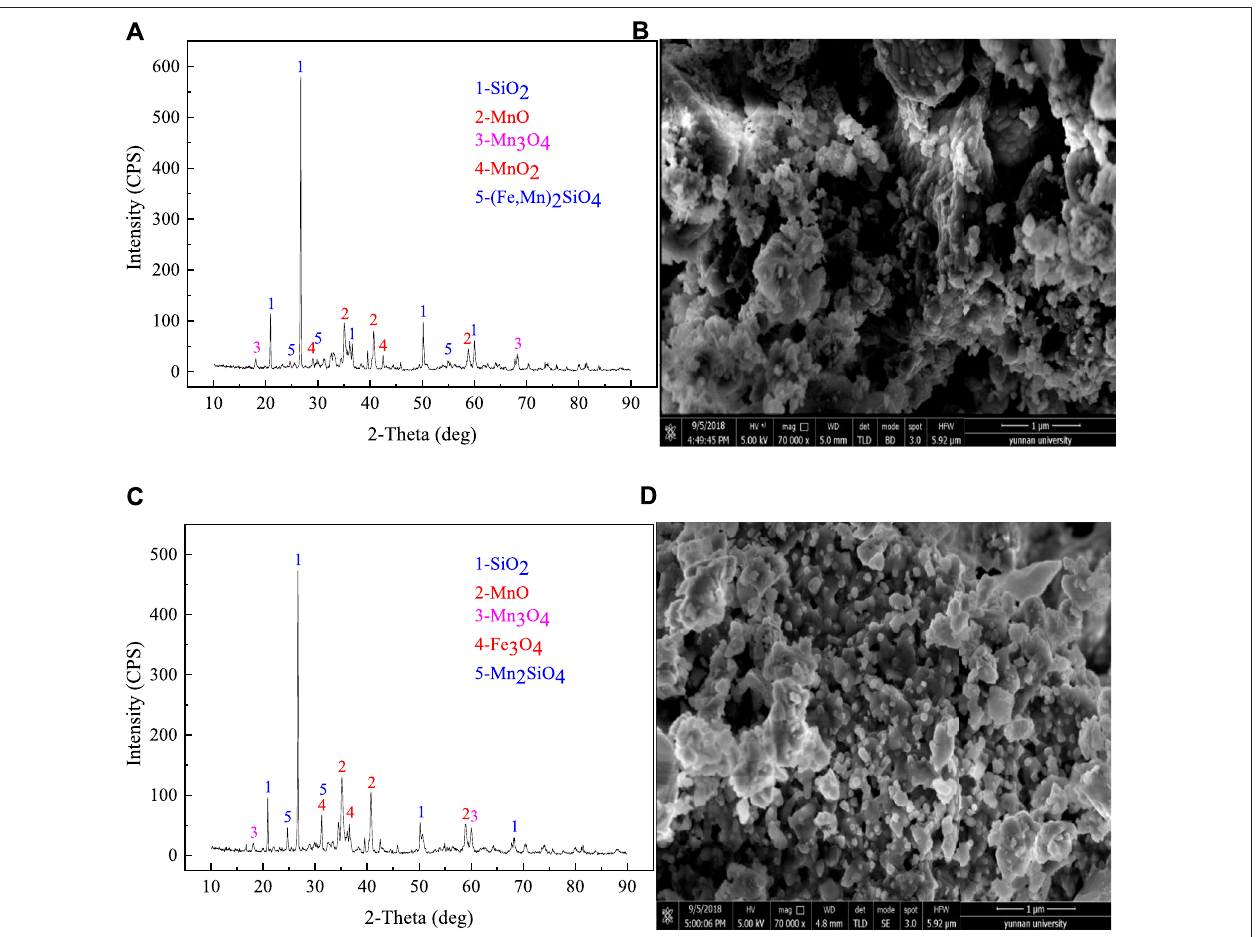
FIGURE 4 | XRD and SEM patterns of the microwave treated pyrolusite, (A) XRD for the pyrolusite treated at 450 ° C for 10 min; (B) SEM, 700,00×; (C) XRD for the pyrolusite treated at 650 ° C for 50 min; (D) SEM, 700,00×.